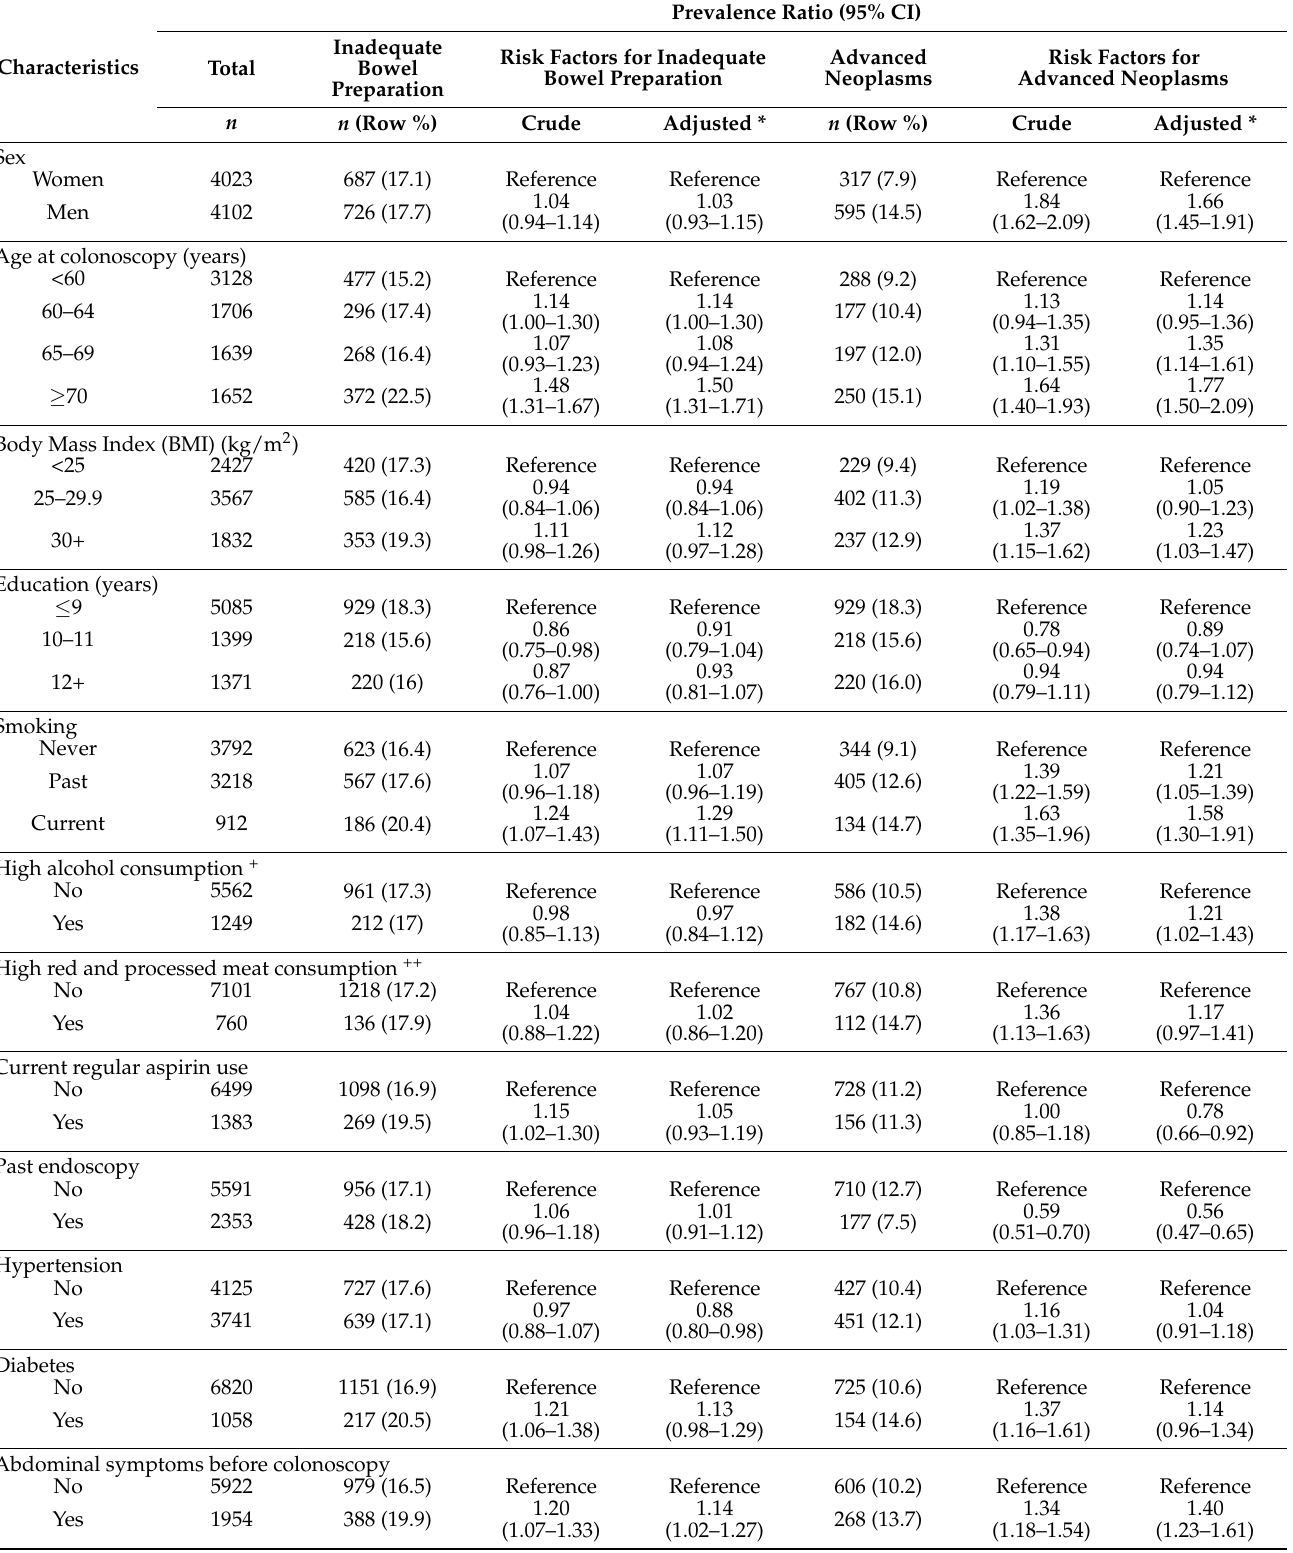
Table 1. Characteristics of the study population, association with inadequate bowel preparation and risk of advanced neoplasms.